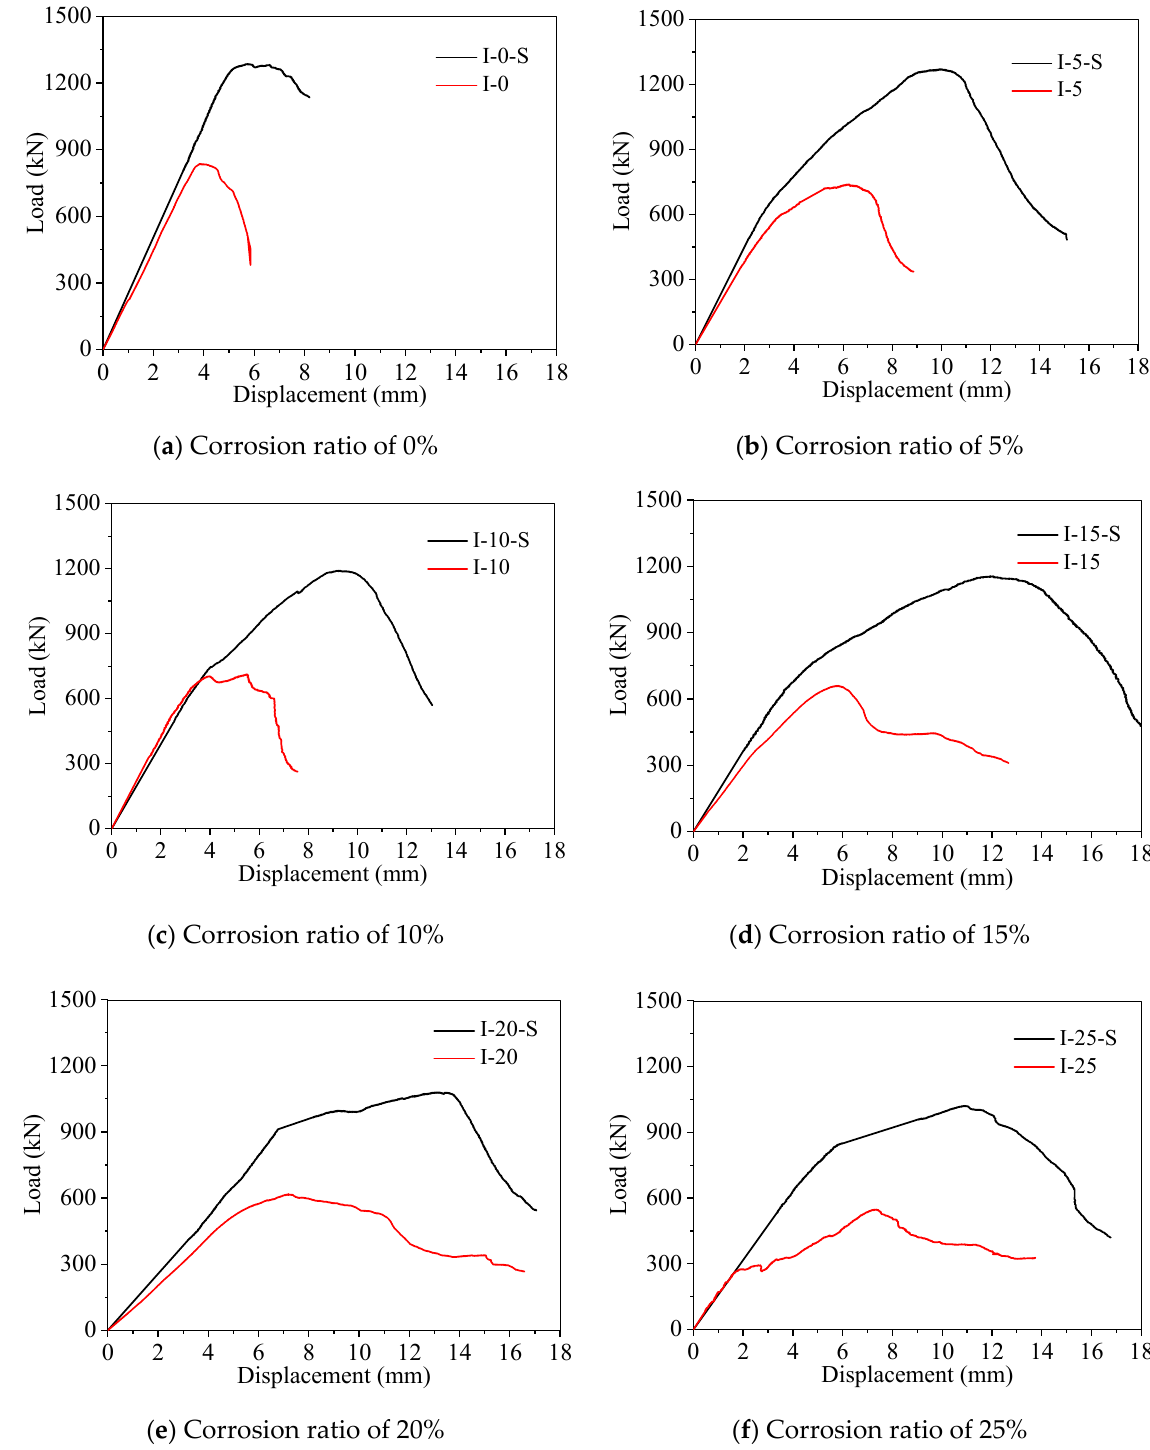
Figure 8. Comparison of load–displacement curves of strengthened and unstrengthened specimens with different corro- sion ratios.